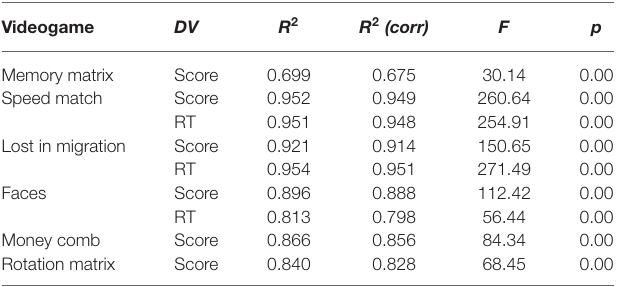
TABLE 2 | Determination coefficients ( R 2 ), F and p values for the six video games.